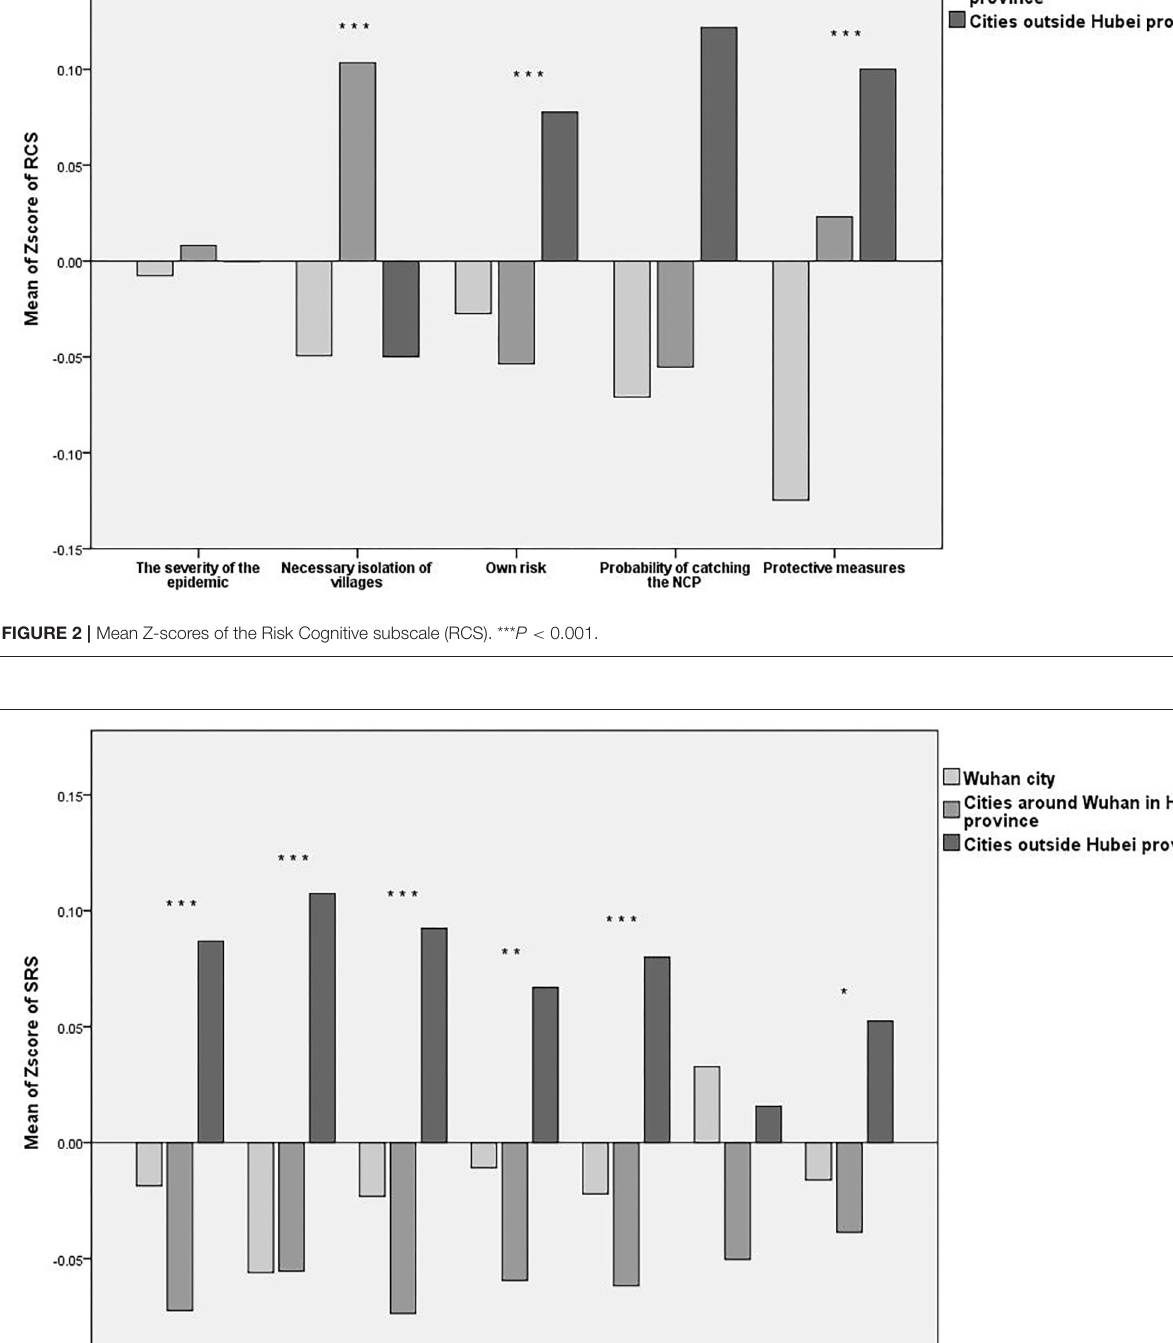
Frontiers in Public Health |